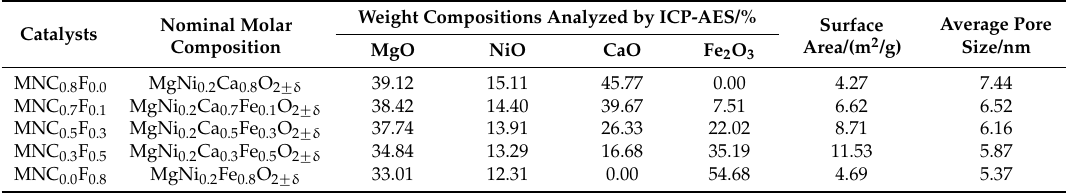
Average Pore Area/(m 2 /g)